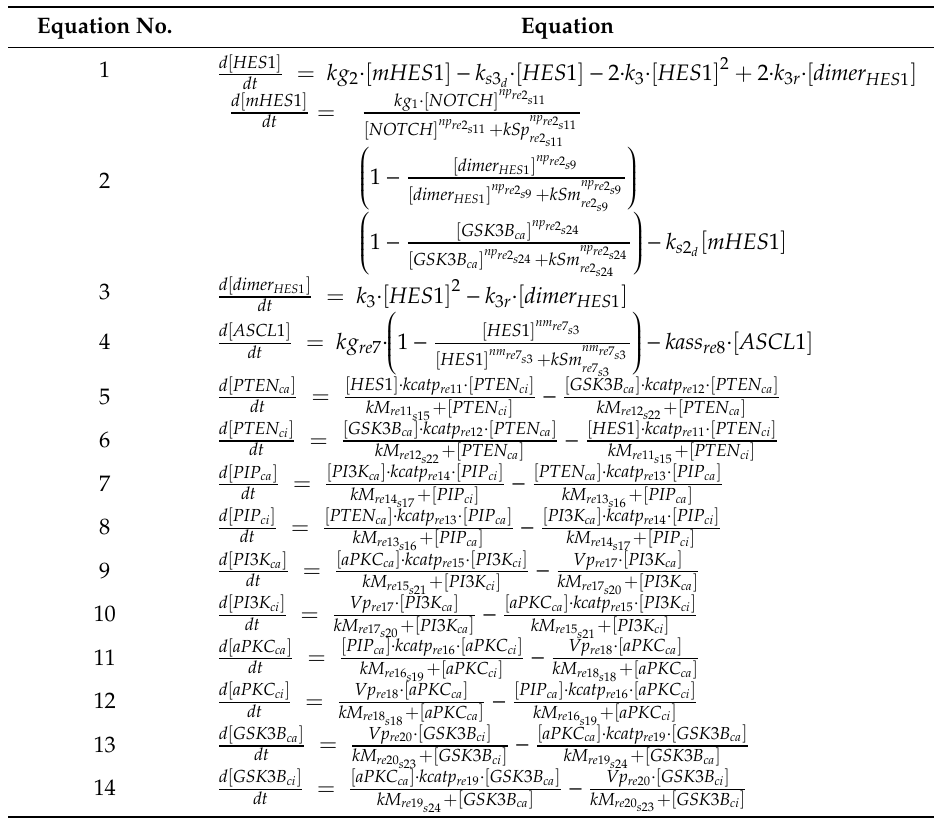
Table 1. Di ff erential equations of the toy